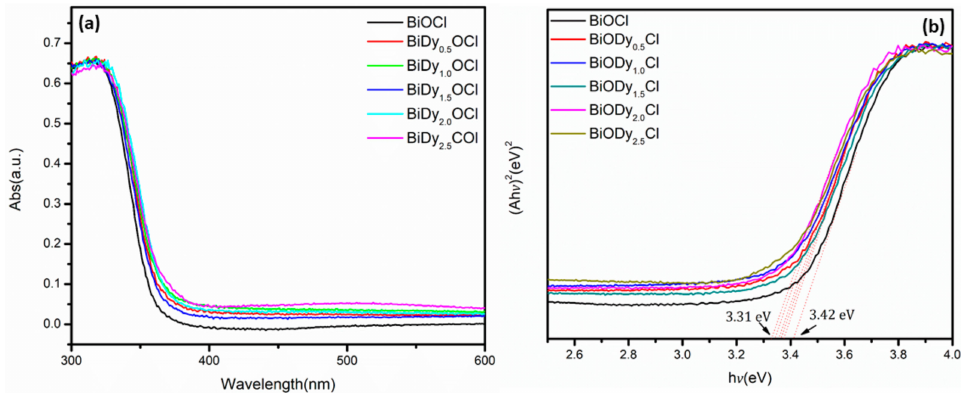
Figure 7. UV–vis diffuses reflectance spectra BiOCl with different Dy contents ( a ) and the corresponding band gap energy ( b ).